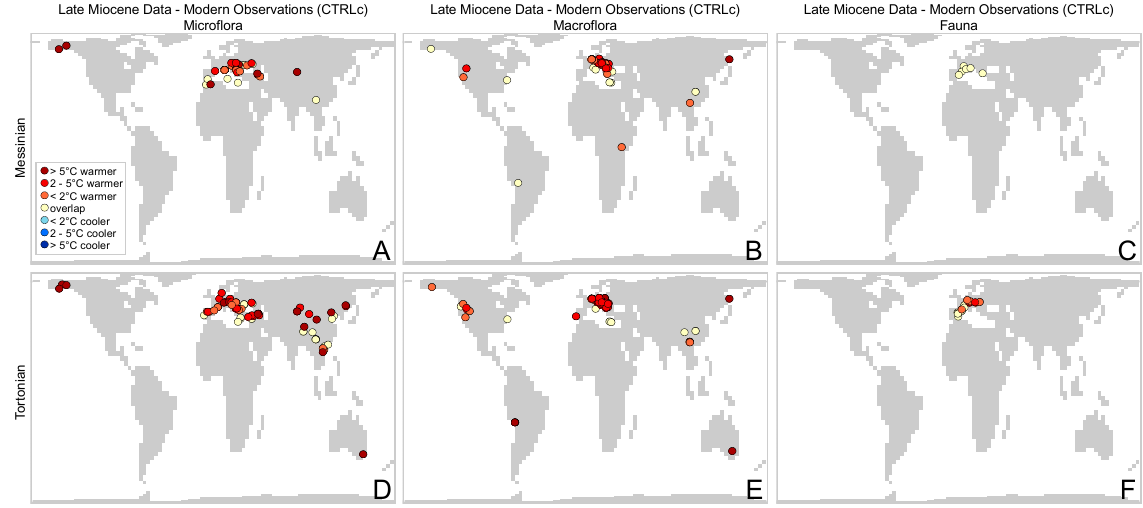
Fig. 7. Results from the model–data comparison for mean annual temperature, late Miocene data–modern potential natural climate estimates.